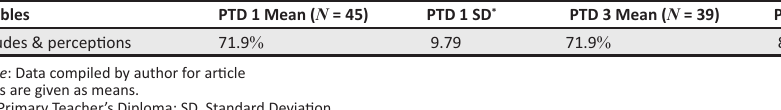
TABLE 1: Attitudes toward and perceptions of extensive